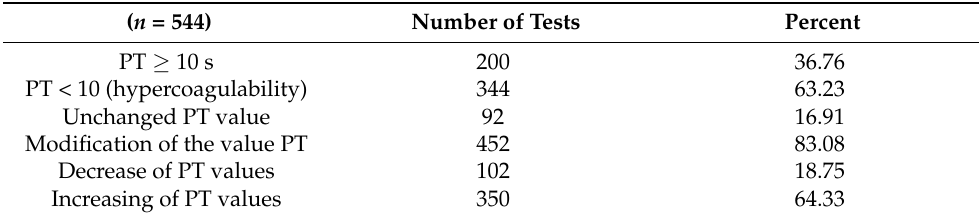
Table 2. Evaluation of hypercoagulability according to the second determination.